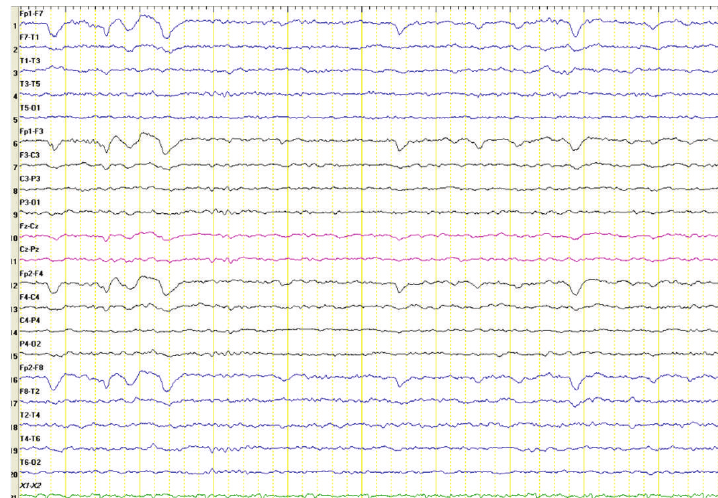
Figure 3: Mild diffuse slowing of the cerebral bioelectrical activity. Background activity was characterized by low voltage slow alpha rhythm (7-8 Hz) with superimposed 4–6 Hz rare theta activity especially in frontotemporal